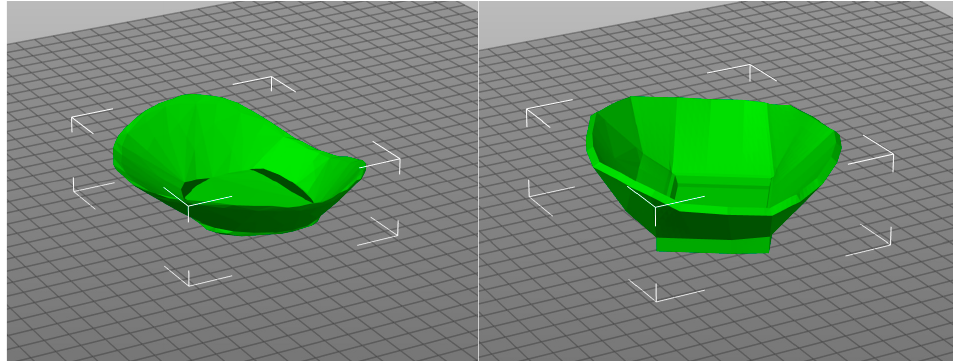
Figure 9. Knee protector made according to a 3D scan of the human body with a wall thickness of 7 and 12 3D printed layers [20].